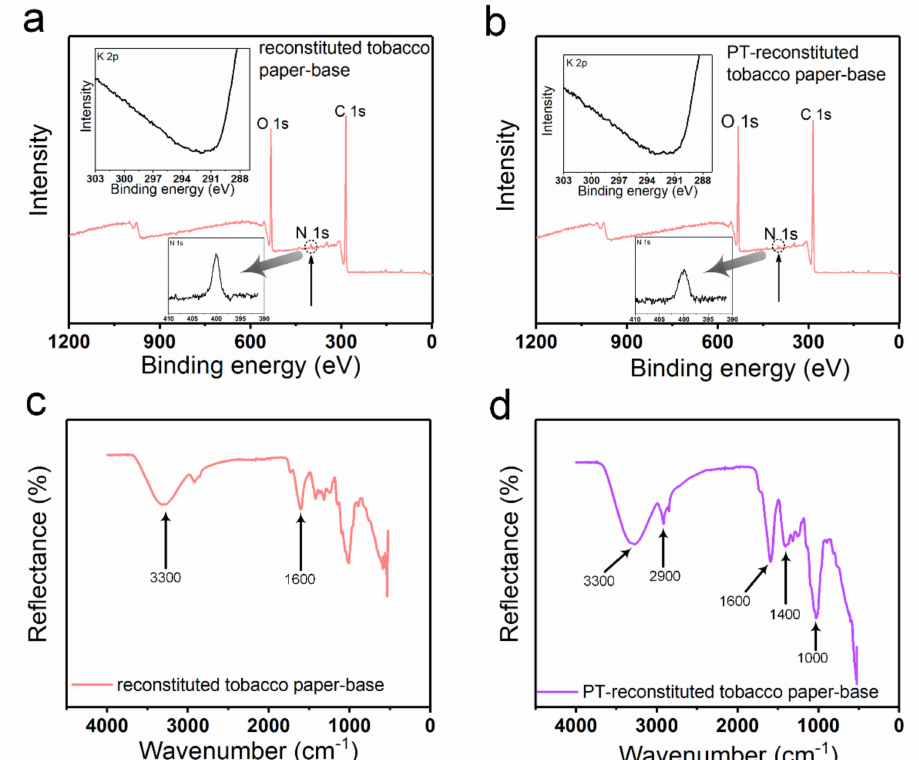
Figure 3. X-ray photoelectron spectroscopy (XPS) of ( a ) reconstituted tobacco paper-base and ( b ) PT- reconstituted tobacco paper-base; Inset: high-resolution spectra for potassium and nitrogen of broad- range XPS spectra. FT-IR spectra of ( c ) reconstituted tobacco paper-base and ( d ) PT-reconstituted tobacco